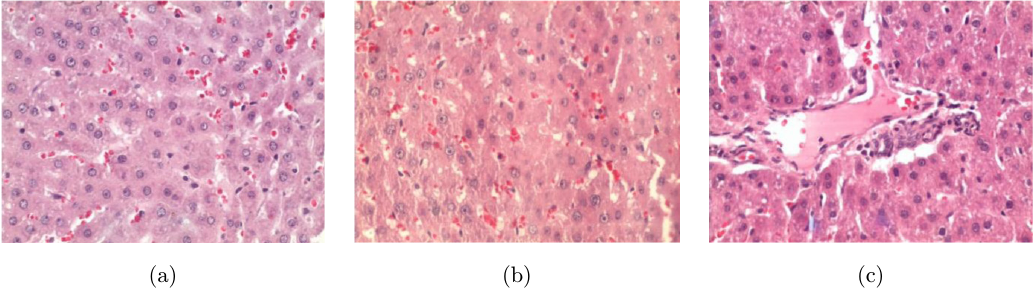
Fig. 2. Histological sections of liver: (a) Comparison group (rats with PC-1). The moderate congestion of the capillaries. (b) Group with laser hyperthermia. The necrosis of individual hepatocytes. (c) Group with PPTT. The hepatocyte necrosis. Extension of vein of portal tract. The blood separation phenomenon — Staining with hematoxylin and eosin. ( (cid:3)